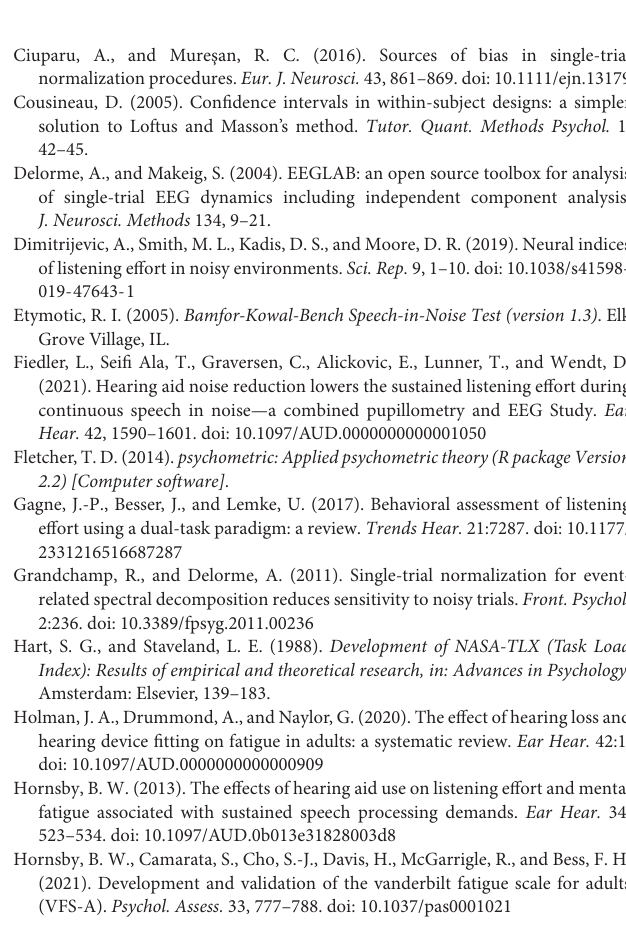
Supplementary Figure 1 | Grand-average event-related spectral power difference from baseline for each level of SNR. Grand mean event-related spectral power difference from baseline across a trial, collapsed across all participants and electrodes. Color scale shows power relative to baseline in decibels [10 ∗ log 10 (average sentence interval power/average baseline interval power)] (Makeig, 1993). Time range shown on the x -axis is 0.5 s before and 3 s after sentence onset. Sentence onset is marked as time zero. White dotted and dashed lines delineate the frequency and time range analyzed for the alpha and theta bands,